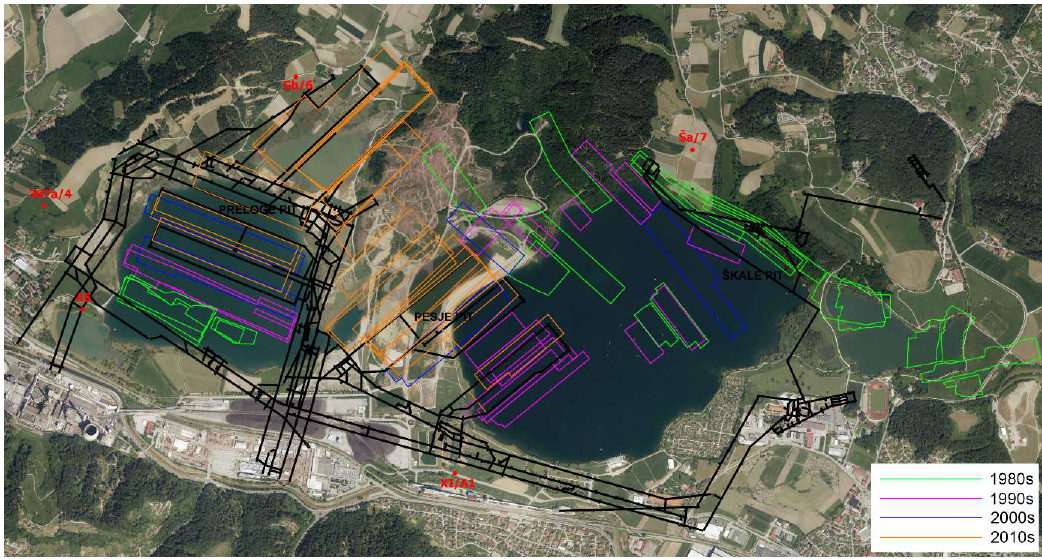
Figure 5. Locations of mining faces from 1980s till today with mine roadways (black) and points of observation networks on the surface (red) that are presented in more detail.